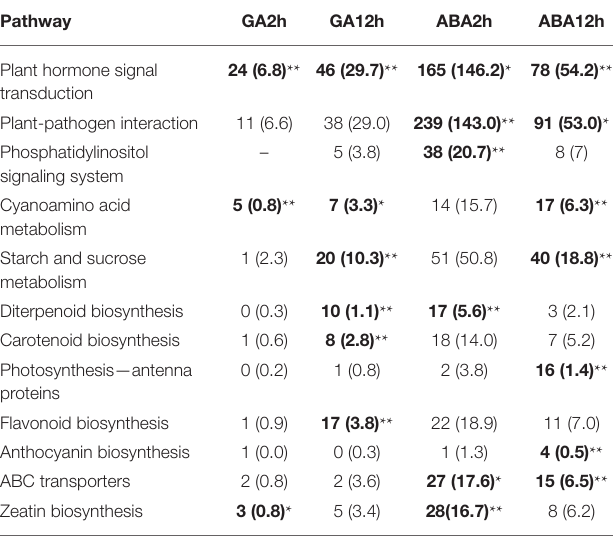
TABLE 3 | Pathways differentially regulated by GAand ABA. Pathway GA2h GA12h ABA2h ABA12h Plant hormone signal